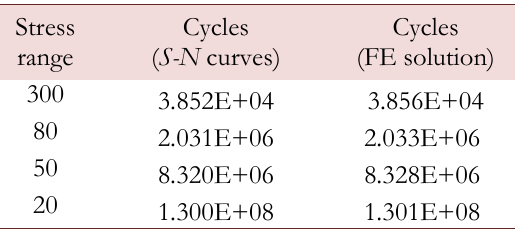
Table 6: Comparison of S-N curve data and numerical results for 2.839 mm initial crack The crack propagation profiles showing the elliptical crack (symmetrical model) growing from its initial size a = 2.839 mm to the outer wall of the pipe are shown in Fig.